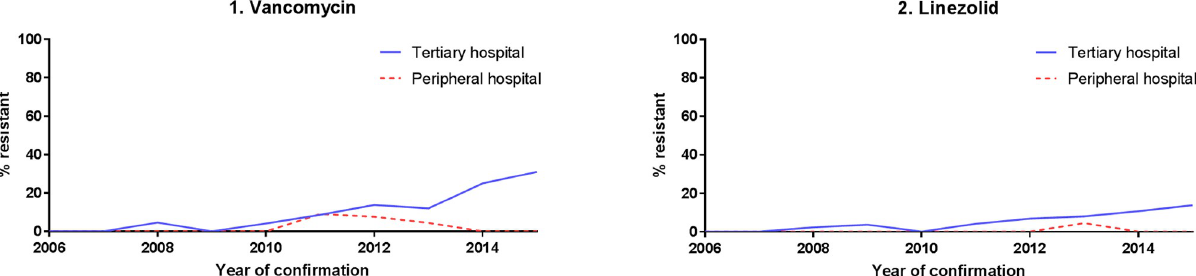
Fig 4. Proportion of antibiotic resistant of Enterococcus faecium strains over time by hospital category.